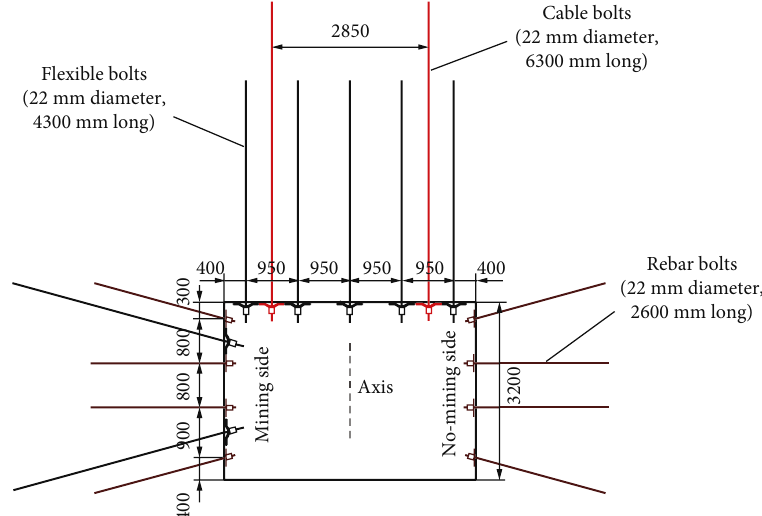
Figure 9: TADL supporting scheme.